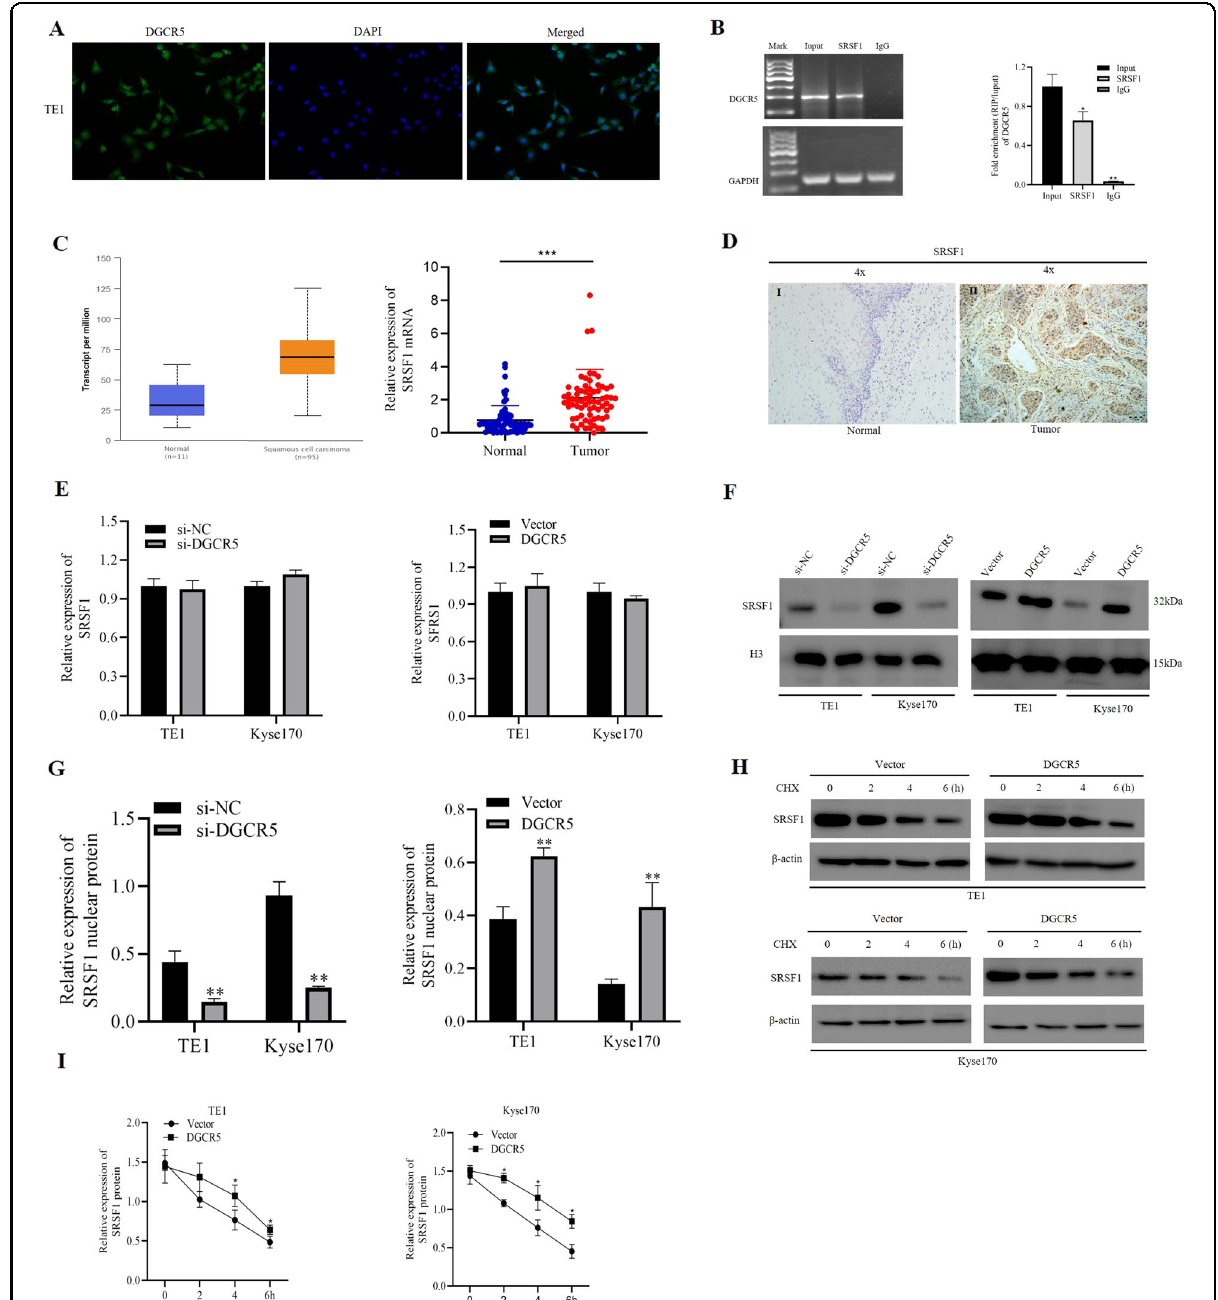
Fig. 3 DGCR5 interacts with SRSF1 and regulates the function of SRSF1 on ESCC cells. A The subcellular location of DGCR5 in TE1 cells was investigated by FISH. Original magni fi cation ×400. B DGCR5 was enriched by SRSF1 in TE1 cell lysates by RIP assays. The expression of DGCR5 was detected by RT-PCR (left) and qRT-PCR (right), which was normalized by GAPDH. C SRSF1 mRNA expression was measured in ESCC tissues compared to non-tumor tissues (the former was detected from the TCGA database, the latter was detected from collected 70 clinical specimens by qRT-PCR. D IHC staining of SRSF1 in the 20 paired ESCC tissues and non-tumor tissues. Example I showed low SRSF1 staining in ESCC non-tumor tissues. Example II showed high SRSF1 staining in ESCC tissues. E qRT-PCR was examined SRSF1 mRNA expression in TE1 and Kyse170 cells transduced with knockdown or overexpression DGCR5. F , G SRSF1 nucleus protein expression by western blotting in TE1 and Kyse170 cells transduced with knockdown or overexpressed DGCR5. H Western blotting analysis of SRSF1 protein in TE1 and Kyse170 cells transduced with overexpressed DGCR5 after 20 µl cycloheximide (CHX) for various times. I Triplicated experiments were performed for statistical analysis about SRSF1 protein with overexpressed DGCR5 after CHX in ESCC cells. * P < 0.05 and ** P <